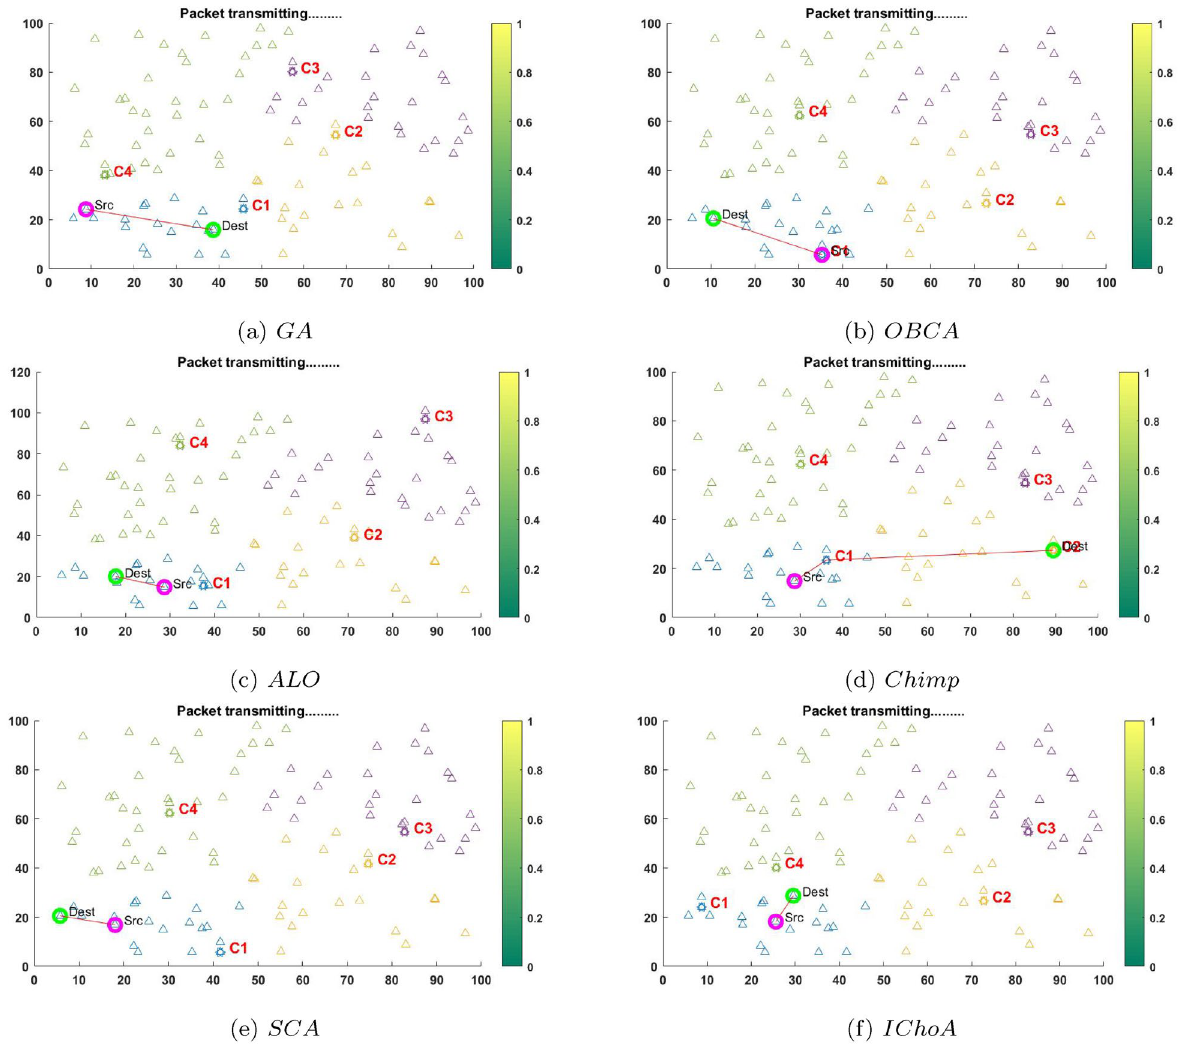
Figure 8. The packet transmitting graphs of metaheuristics on F 6